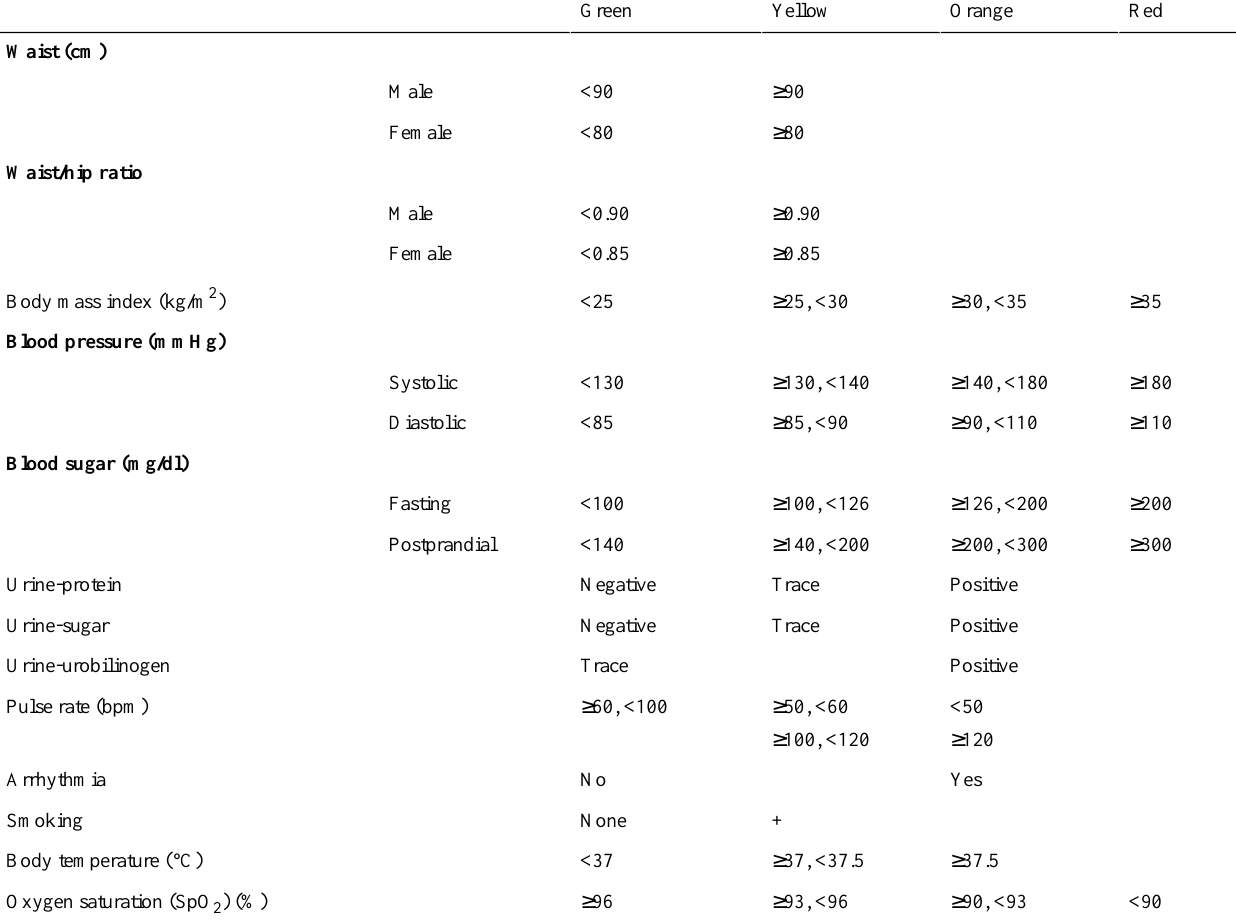
Table 1. Bangladesh-logic: criteria for risk